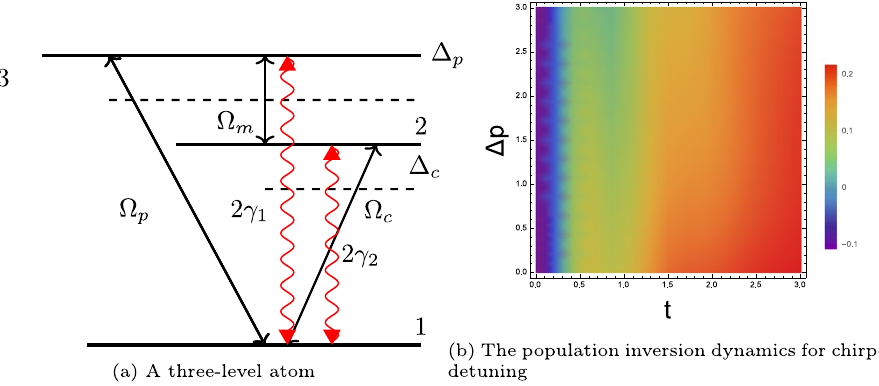
Figure 2. ( a ) A three-level atom excited by a q-deformed control laser and a weak probe field, ( b ) The temporal dynamics of the atomic population inversion for various